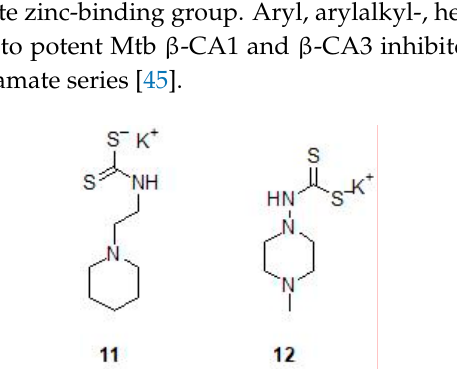
Figure 6. Chemical structures of dithiocarbamates ( 11 ) and ( 12 ).